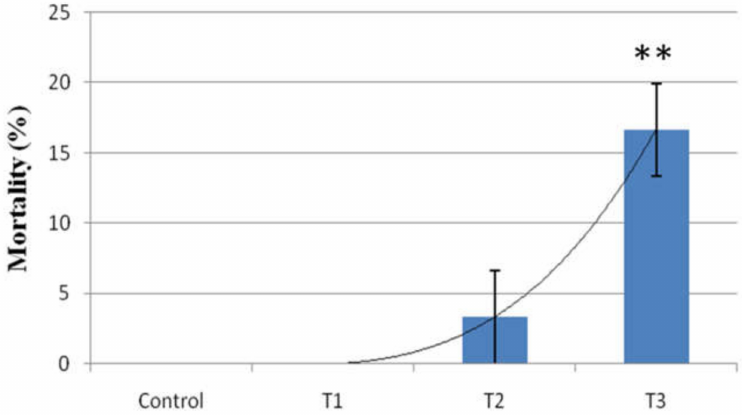
Figure 6. Mortality rate of arsenic-exposed rohu carp in different treatment groups. Column with (**) sign indicates significant difference ( p < 0.01) compared to other groups. Control: 0.0 mg/L, T1: 2.5 mg/L, T2: 15 mg/L and T3: 30